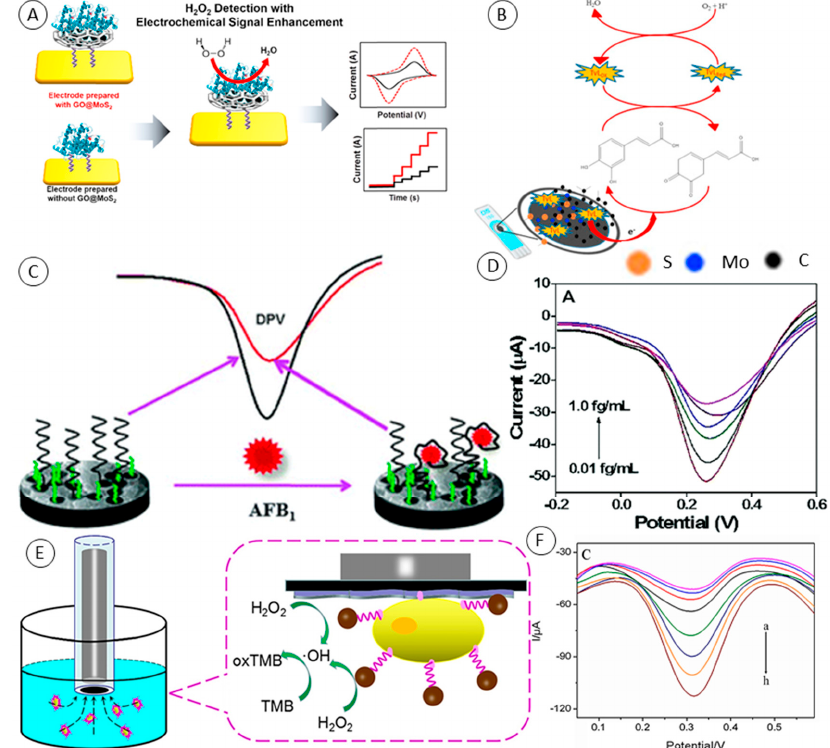
Figure 4. ( A ) Schematic of electrochemical biosensors composed of myoglobin (Mb) and of GO / MoS 2 with electrochemical enhancement for H 2 O 2 detection. From Yoon et al. [60]. ( B ) Schematic representation of construction and the detection principle of screen-printed carbon electrode modified with graphene quantum dots, MoS 2 and laccase as a ca ff eic acid biosensor. From Vasilescu et al. [69]. ( C ) Schematic representation of the reduced graphene oxide / molybdenum disulfide / polyaniline nanocomposite-based electrochemical aptasensor for detection of aflatoxin B 1 fabrication. ( D ) Di ff erential pulse voltammetry (DPV) responses of the aptasensor after 20 min incubation with 0.0100, 0.0156, 0.0313, 0.0625, 0.125, and 1.00 fg · mL − 1 AFB 1 . Both from Geleta et al. [72]. ( E ) Schematic illustration of magnetic beads assisted bi-nanozyme signal amplification for detection of circulating tumor cells. ( F ) DPV responses to MCF-7 / aptamer / Fe 3 O 4 NPs / rGO / MoS 2 / GCE-fabricated cytosensor after capturing di ff erent concentrations of MCF-7 cells from (a) to (h): 0, 15, 20, 25, 30, 35, 40 and 45 cells · mL − 1 in 0.01M PBS (pH = 5.0) with 0.1mM of H 2 O 2 and 0.2mM of TMB. Both from Tian et al.